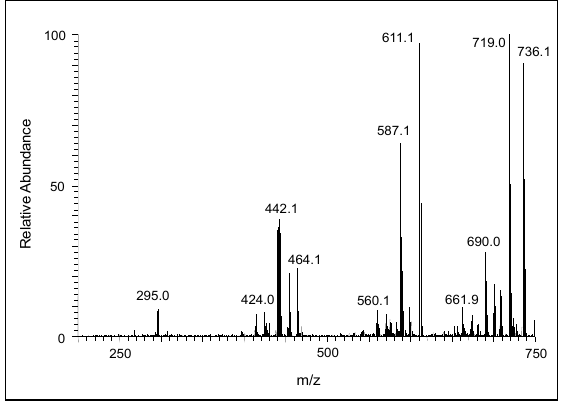
Figure 9. The CID mass spectrum of the ion with an m / z value of 736 amu.